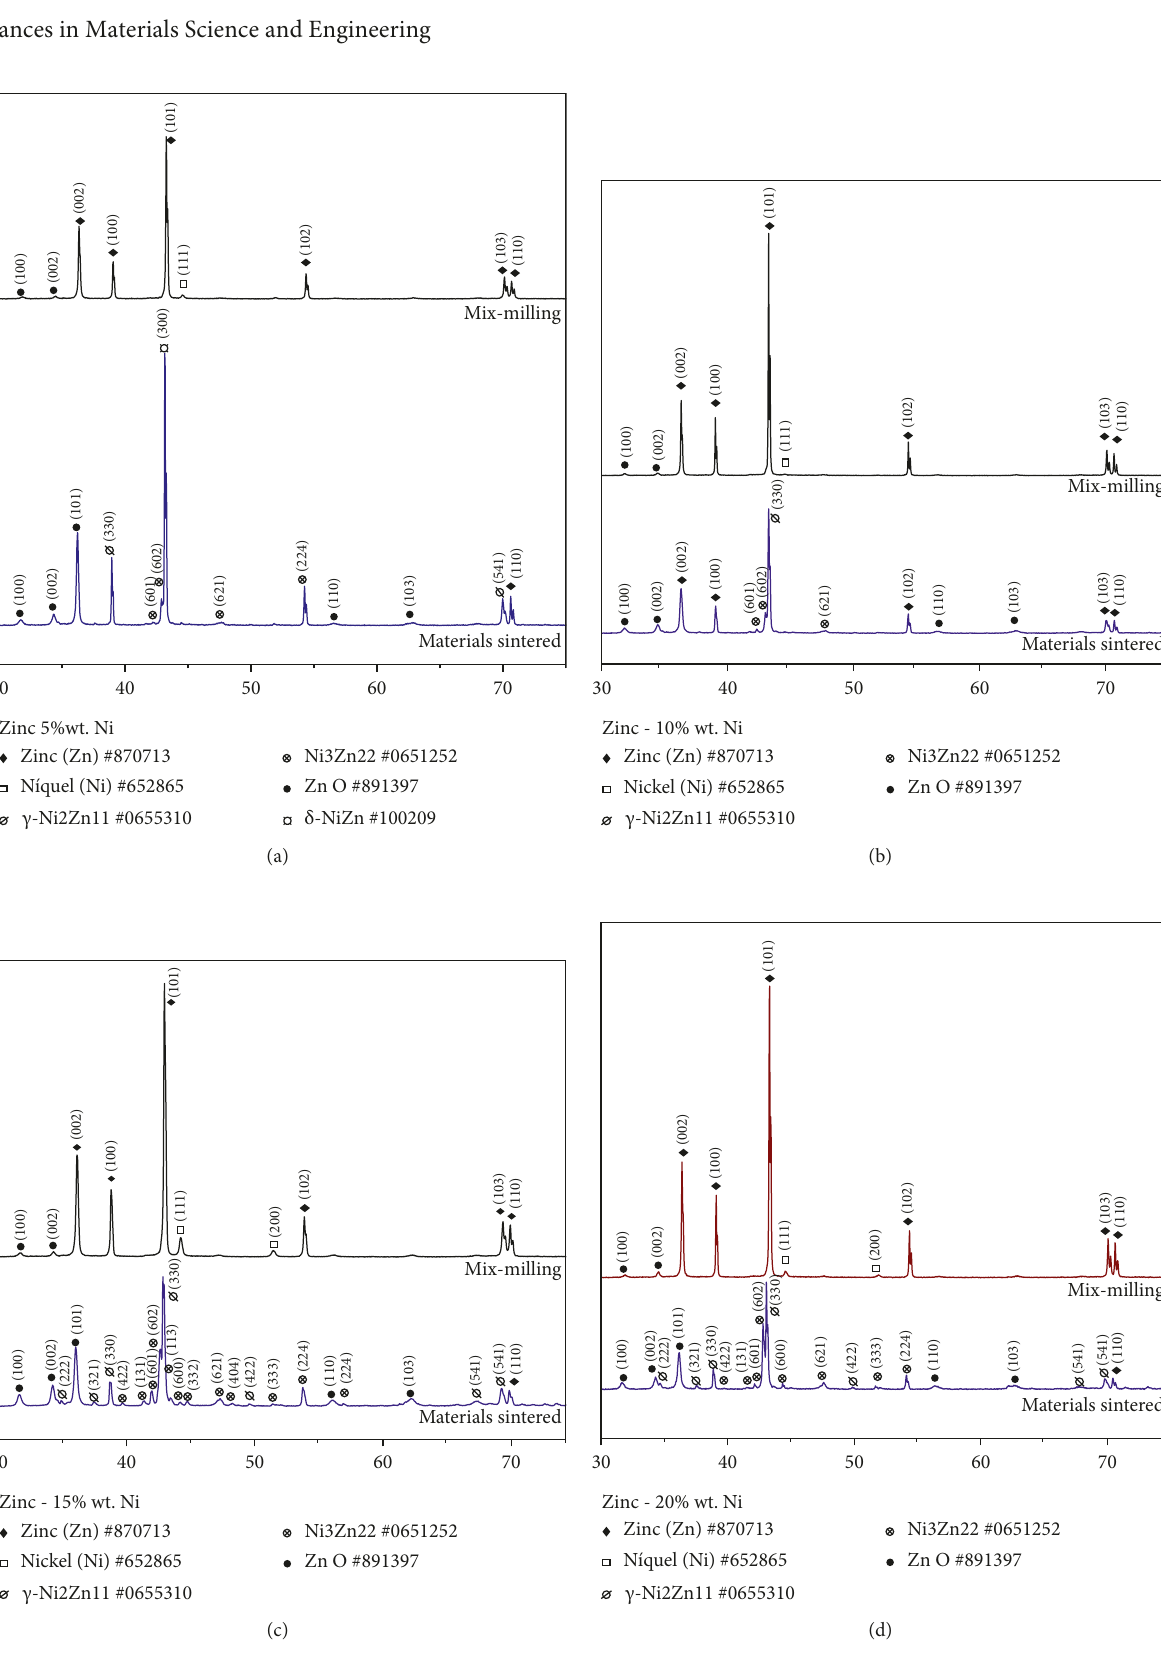
Figure 11: X-ray diffraction spectra of milling powders and sintered materials of systems Zn-Ni (c) Zinc 15%wt. Ni. (d) Zinc 20%wt.